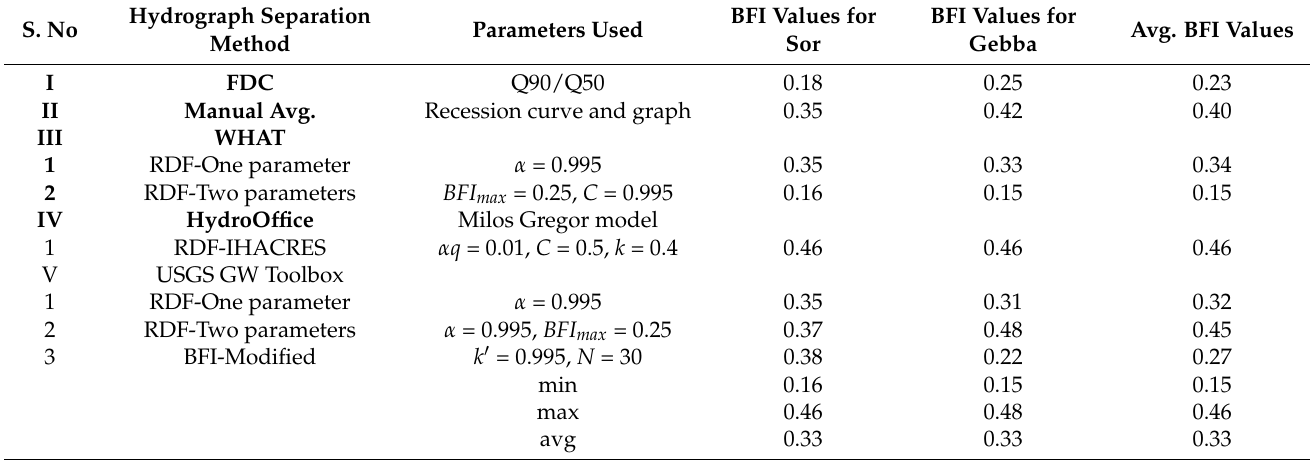
Table 7. Summary of methods, parameters, and BFI values for selected baseflow separation techniques. S.